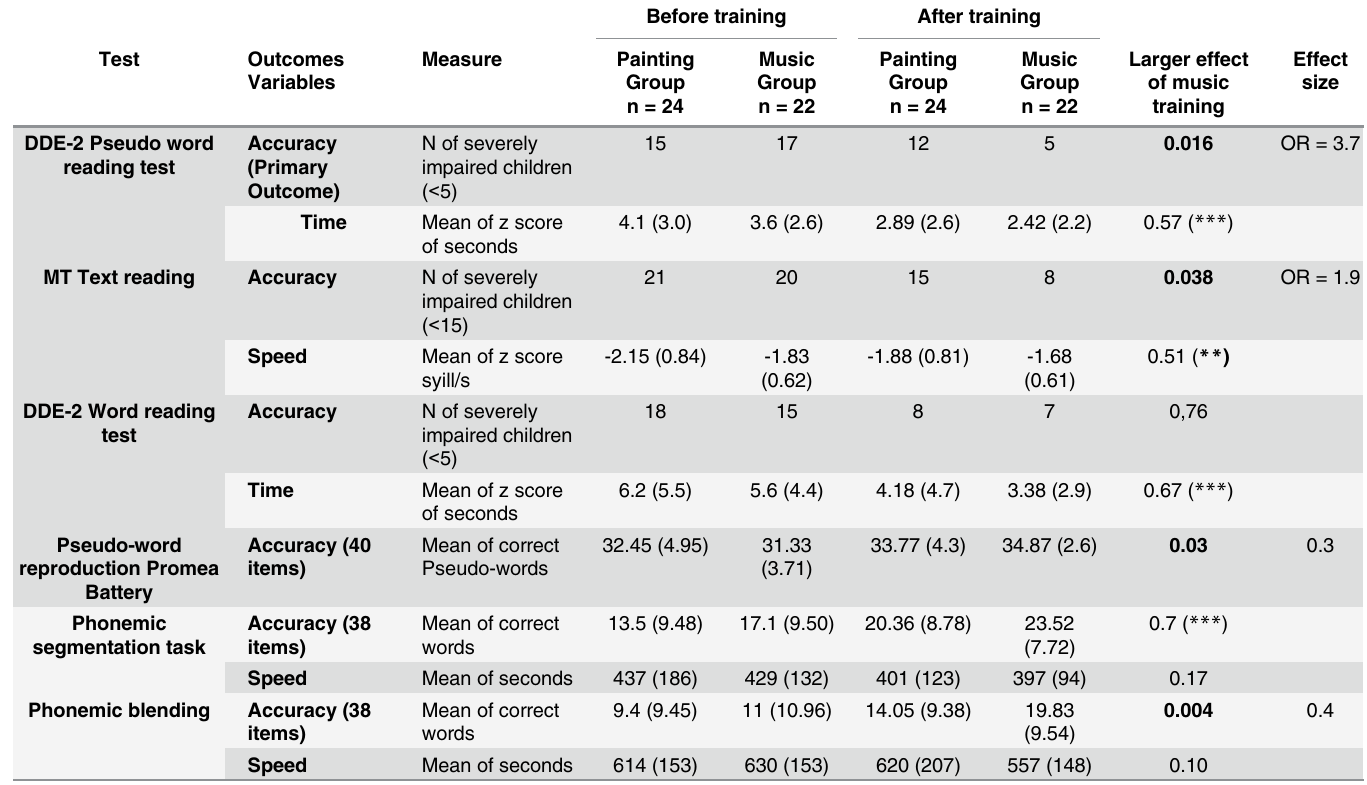
list of 102 Italian words and 48 Italian pseudowords words ( DDE-2) [43]. Self-esteem. General competence self-esteem was evaluated using the corresponding sub- scale “ Multidimensional test of self-esteem-TMA ” [44]. Table 2. Summary of reading and phonological awareness results before and after training. Before